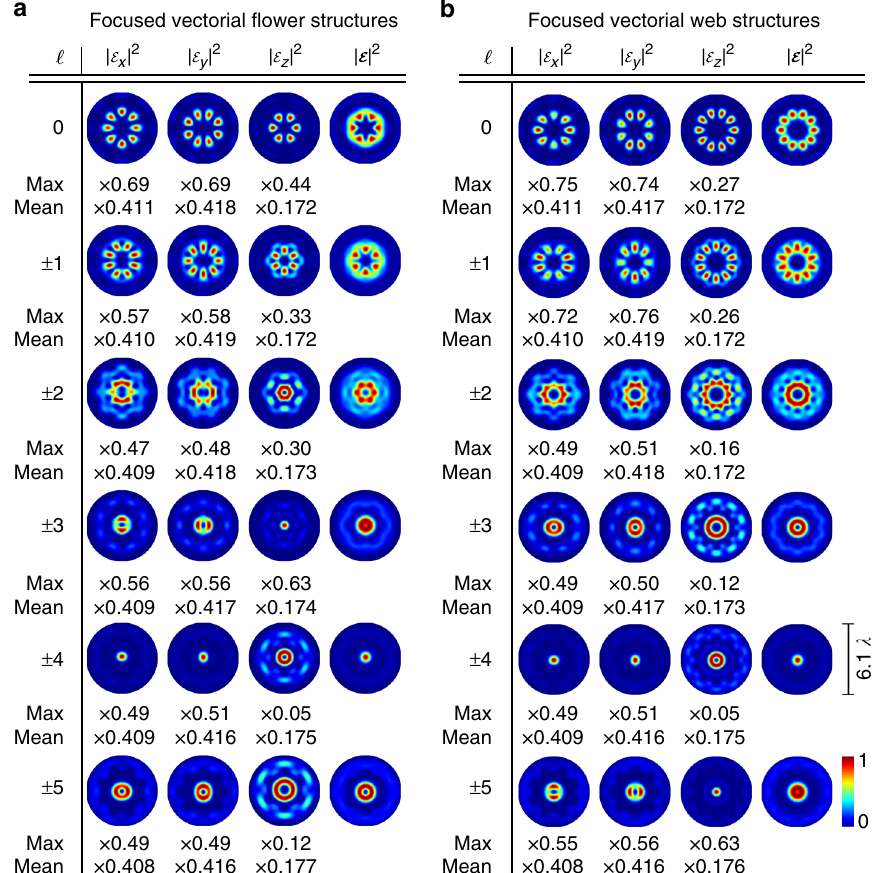
Fig. 2 Numerics on tailored non-paraxial light fi elds E ð x ; y ; 0 Þ realized by tightly focusing tailored vectorial fi elds. Vectorial fl ower ( a ) or web ( b ) structures ( σ 12 = ±8) with additional phase vortices of charge ‘ are considered as input fi elds. The total focal intensity j E j 2 as well as intensity contributions jE x ; y ; z j 2 of transverse ( E x ; y ) and longitudinal ( E z ) polarization components in the focal plane ( x , y , 0) are presented (NA = 0.8). The relation of the maximum (max) or mean value of jE x ; y ; z j 2 to the maximum or mean of j E j 2 , respectively, is given below images